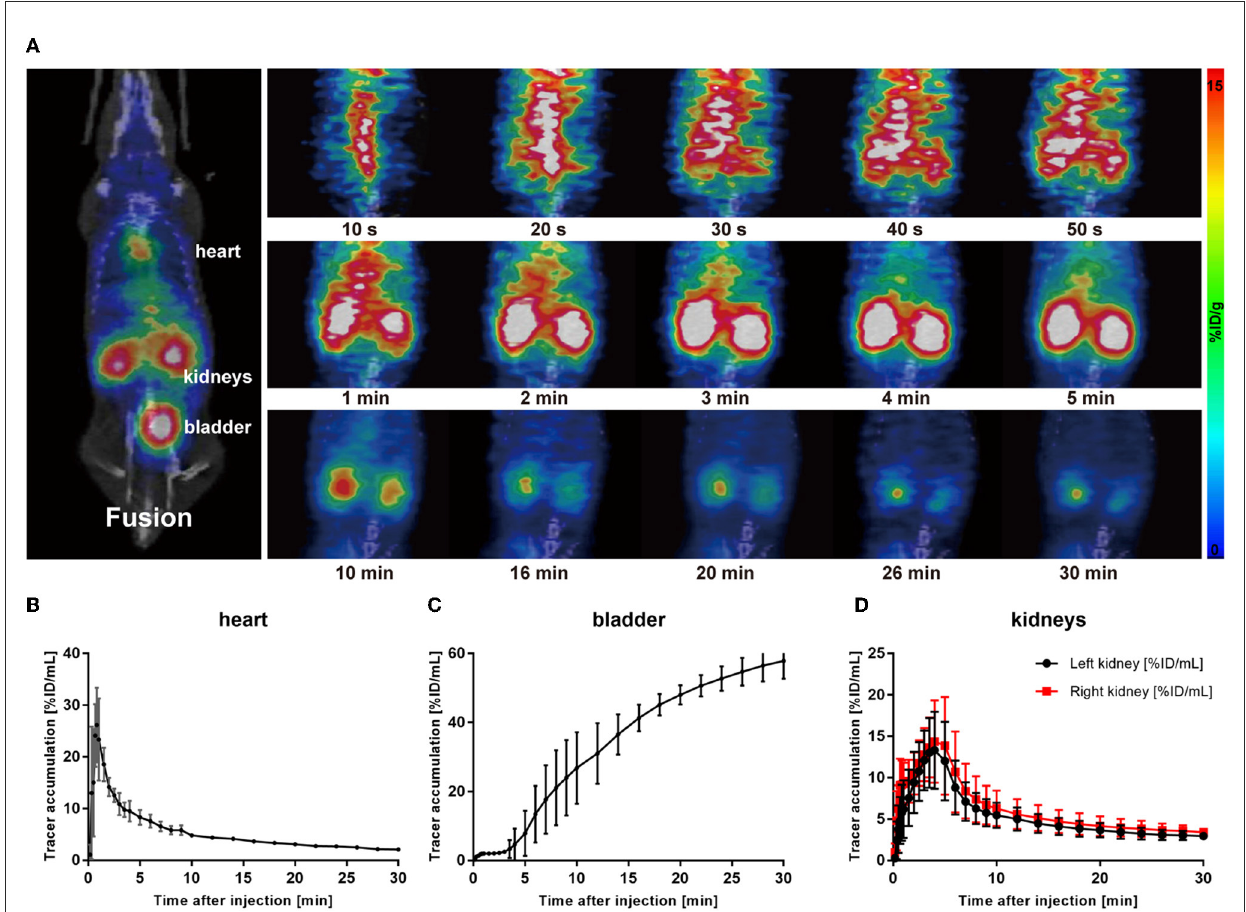
FIGURE1 68 Ga-EDTA dynamic positron emission tonometry (PET)/computed tomography (CT) imaging of healthy mice. (A) Coronal fusion images of 68 Ga-EDTA dynamic PET/CT scanning in healthy mice after intravenous injection of 68 Ga-EDTA. (B) The heart time-activity curve (TAC) of healthy mice was obtained via PET imaging. (C) The bladder TAC of healthy mice was obtained via PET imaging. (D) The renograms of healthy mice were obtained via PET